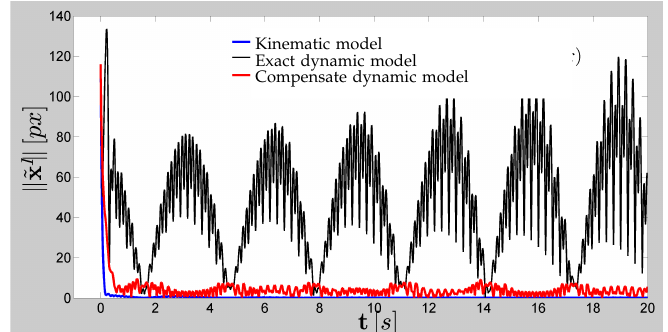
Figure 7. The control error for the following task.